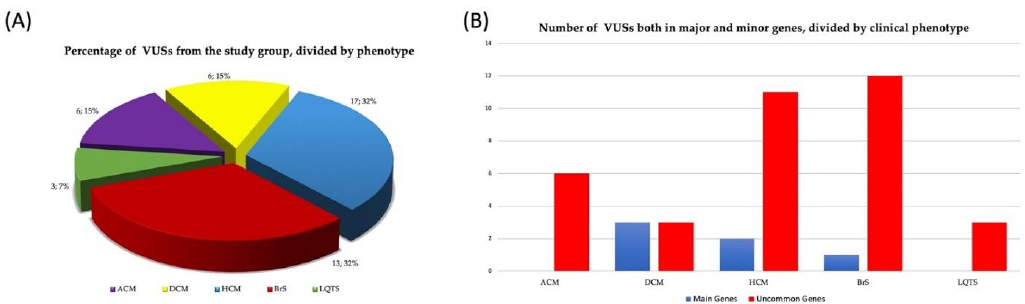
Figure 4. ( A ) Percentage and number of VUSs collectively identified in the study cohort and ( B ) divided by main and uncommon genes according to clinical phenotype.